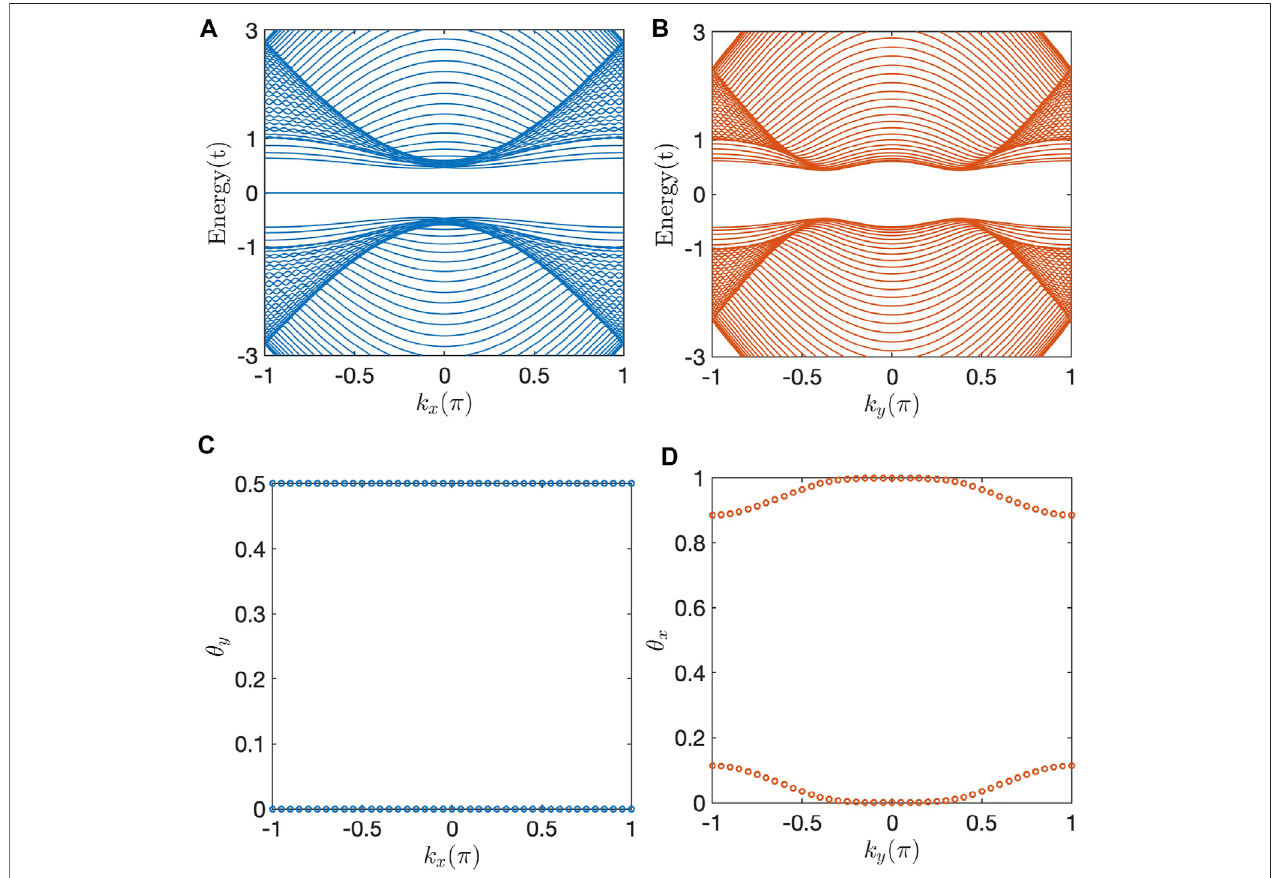
FIGURE 3 | (A) Energy spectrum of a ribbon along x -direction with width W y = 20. Notice the fl at band at zero energy. (B) Energy spectrum of the ribbons along y - direction with width W x = 20. (C) Wannier bands θ y as a function of k x . (D) Wannier bands θ x as a function of k y . The other parameters are t x = 1.2 t and t y = 1.8 t